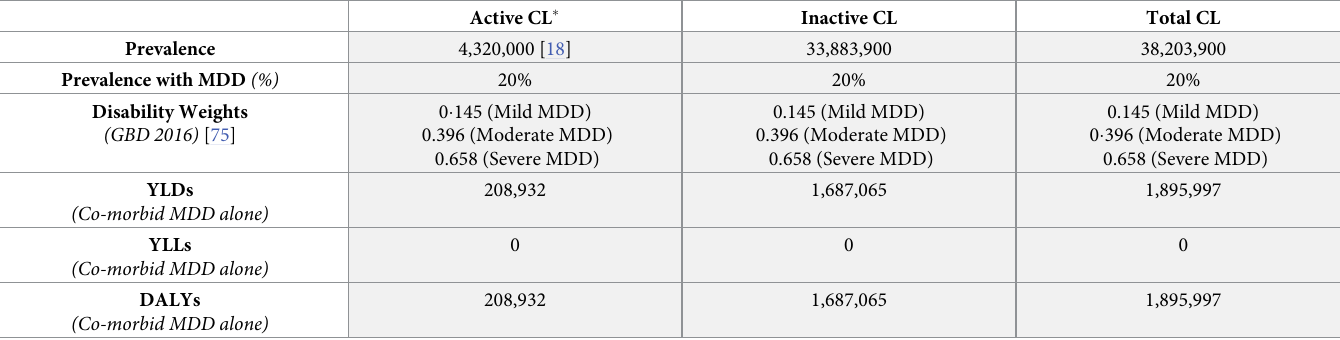
Table 7. Estimating the burden of Major Depressive Disorder in cutaneous leishmaniasis.